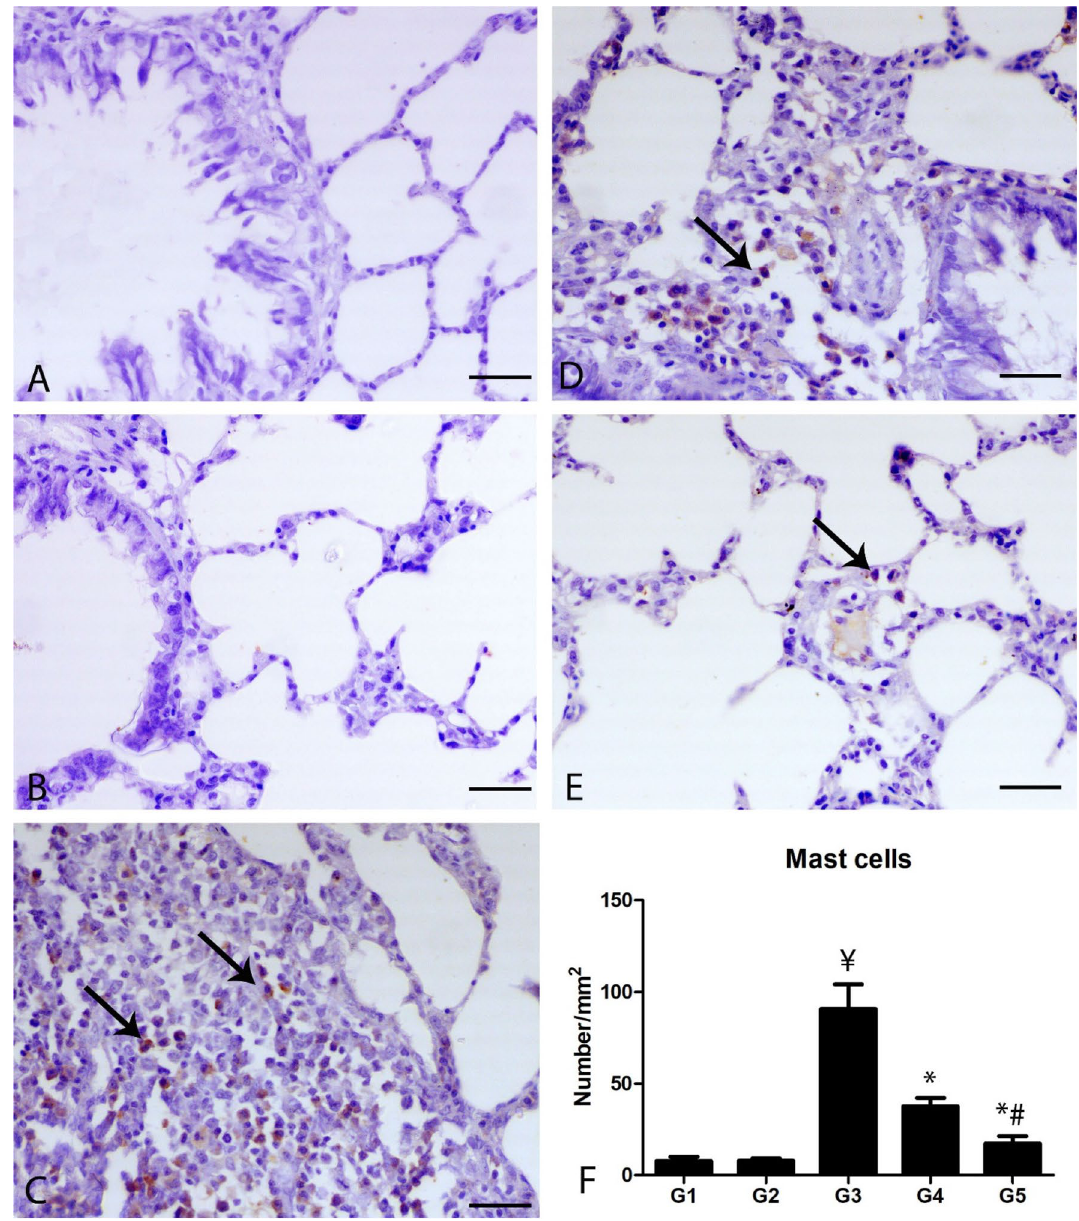
Figure 4. Photomicrograph of the pulmonary sections of the different groups immunostained with C-KIT antibody. (A) The lung of G1 and (B) lung of G2 showing scarcely expression of C-KIT antibody within the pulmonary tissues. (C) Lung of G3 showing numerous C-KIT positive mast cells (arrows). (D) Lung of G4 showing decrease of C-KIT positive mast cells. (E) Lung of G5 showing marked decrease C-KIT positive mast cells, bar = 50 µm. (F) Quantitative score of the number of C-KIT positive mast cells. ¥ indicates significance in comparing with G1 (P < 0.001), * indicates significance in comparison with G3 (P < 0.001) and # indicates significance in comparison with G4 (P <